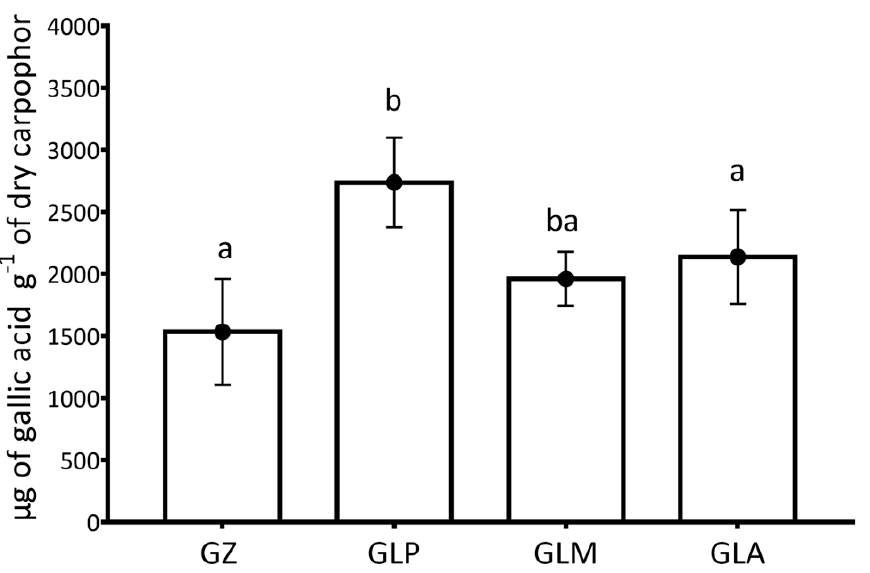
Figure 2. Antioxidant capacity measured in the different carpophores of GL and GZ of the CUPRAC study. Different letters indicate significant differences between taxa ( p < 0.05). GZ: GZ from Shenzhen, China. GLA: GL from Aveiro, Portugal. GLM: GL from Madrid, Spain. GLP: GL from Palencia, Spain.